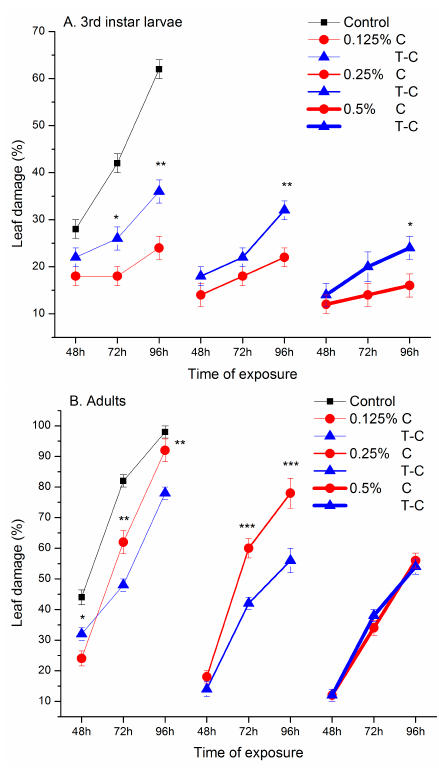
Figure 1. Percentage of leaf damage by CPB larvae ( A ) and adults ( B ) exposed to different concentra- tions of pure camphor (C, red lines) and the thujone-camphor mixture (T-C, blue lines). Asterisks indicate significant differences between C and T-C (LSM contrasts, * p < 0.05, ** p < 0.01, *** p < 0.001). Analysis of the between-subject effects in repeated measures two-way ANOVA showed that leaf damage was significantly affected by the monoterpene ketone(s) type and their concentration both in larvae and adults (significant K and C effects in Table 1). On average, pure camphor provided better protection against CPB larvae than the ketone mixture (grand means for C/T-C: 17.33/23.78%) with significant differences recorded at the end of observation (96 h) (Figure 1A). The thujone-camphor mixture was more effi- cient against adults (grand means for C/T-C: 48.44/41.56%), however, at the highest con- centration both ketone formulations were equally effective (Figure 1B). Leaf damage gradually decreased from the lowest to the highest concentration. On average, a comparison between the lowest and highest concentrations revealed 30% and 40% decreases in leaf damage caused by larvae and adults, respectively. The pattern of the decrease in leaf damage was similar in larvae exposed to pure camphor or thujone- camphor. In contrast, significant K × C interaction was recorded in adults (Table 1). At medium concentration (0.25%) adults exposed to the ketone mixture caused a significant reduction in leaf damage relative to the lowest concentration (0.125%) ( p = 0.001), whereas leaf consumption by camphor-exposed adults showed no differences between these groups ( p = 0.206). Leaf consumption was significantly increased during the time of exposure to ketones both by larvae and adults (Figure 1, significant T effect in Table 1). Analysis of within- subject effects revealed that the shape of the response curves differed between ketone(s) (significant T × K interaction in Table 1). Namely, in larvae the increase in leaf damage observed from 48 to 72 h was significant for the ketone mixture ( p = 0.004) and non-signif- icant for pure camphor ( p = 0.562). In adults, the leaf damage increase was significant be- tween 48 h and 72 h and between 72 and 96 h, but the increase slope was steeper for pure camphor (Figure 1). While time response curves were parallel for the different concentra- tions in larvae (non-significant T × C interaction term in Table 1), in adults the curves became steeper at higher concentrations (Figure 1, significant T × C interaction term in Table 1).